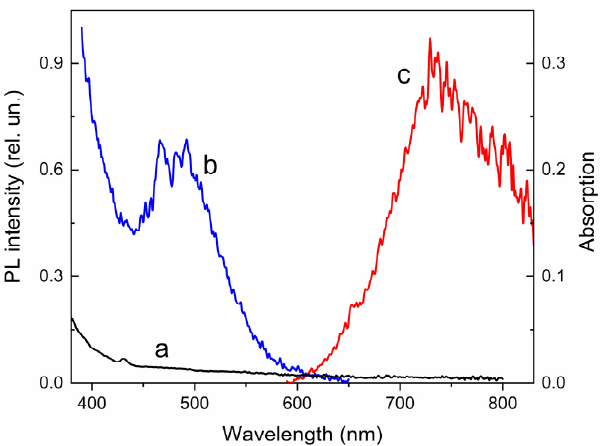
Figure 4. The absorption ( a ), PL excitation ( b ) and PL ( c ) spectra of 2 . λ em = 730 nm ( b ), λ exc = 480 nm ( c ), T = 298 K.